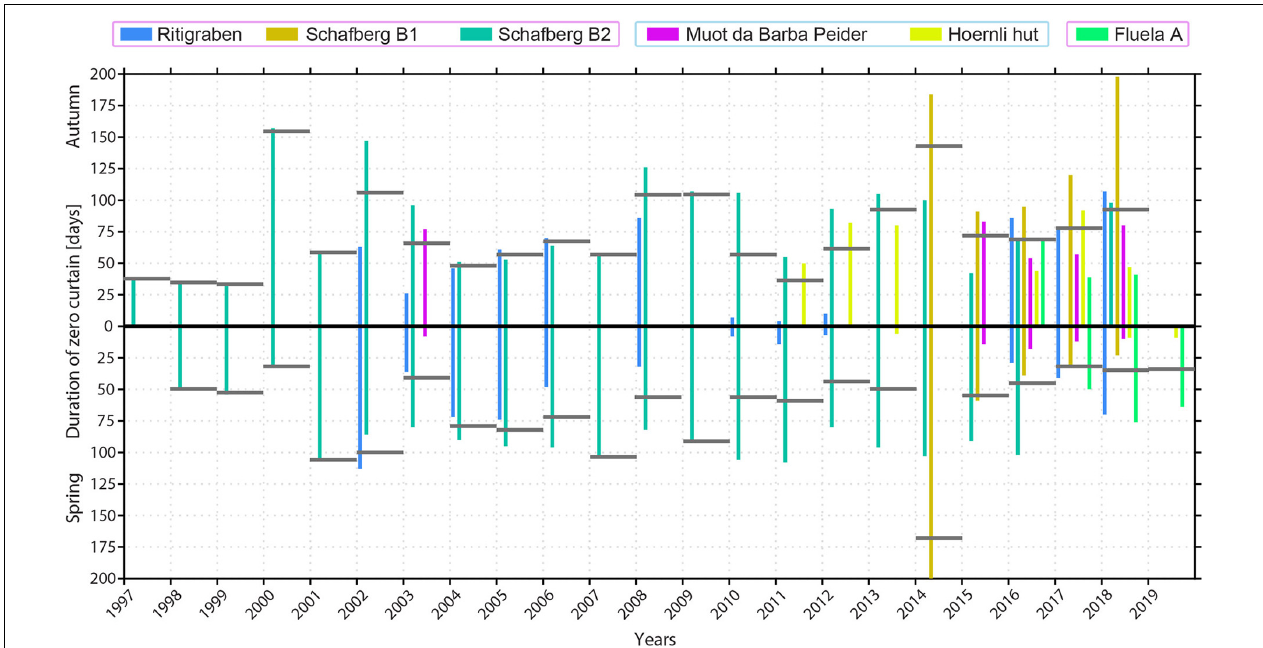
FIGURE 11 | Duration in days of spring zero curtains (downward pointing bars) and autumn zero curtains (upward pointing bars). Bars represent the time periods in all permafrost boreholes and when both spring and autumn zero curtains exist at the lowest sensor in the active layer (section “3.2.6 Zero Curtain”). Grey horizontal bars represent the mean of all (autumn respectively spring) zero curtain days over all boreholes that have data in that year. The coloured frames indicate the ice content of the boreholes: pink for ice-rich, and light blue for ice-poor